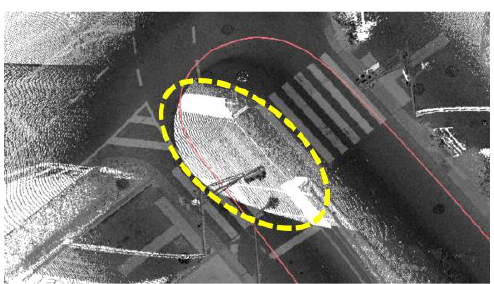
Figure 11. Missing LiDAR due to MMS turning left or